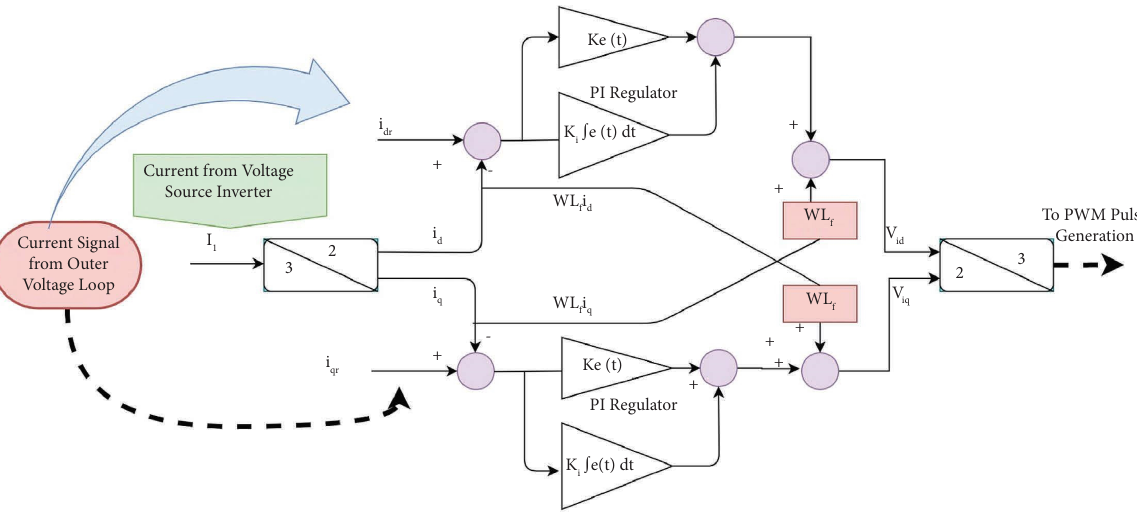
Figure 6: Design of inner controller